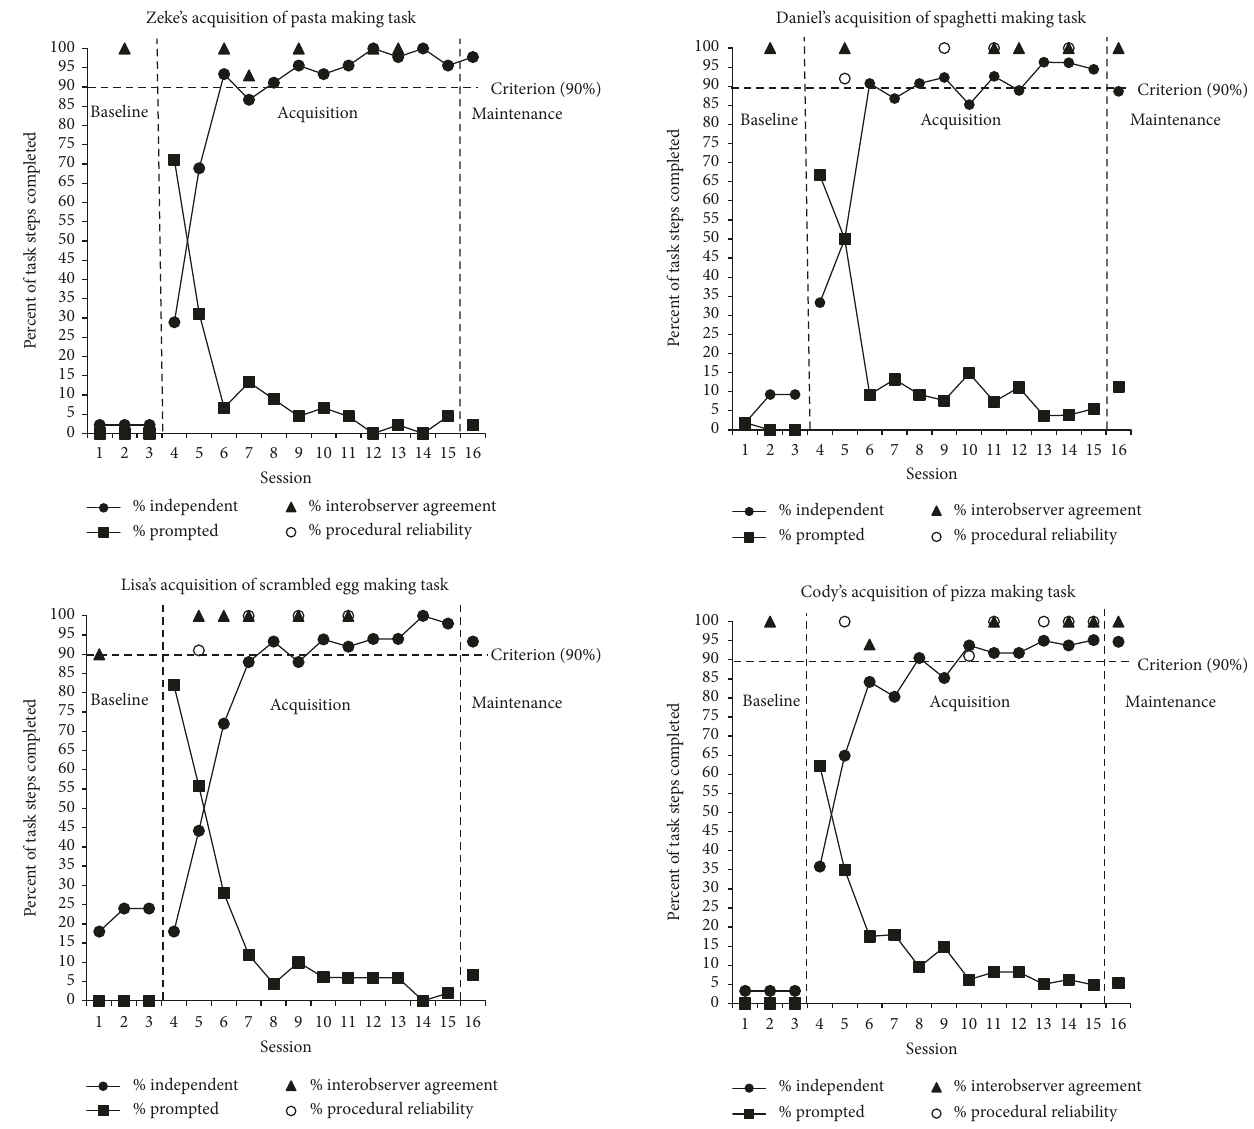
Figure 4: Percentage of task steps completed independently and with prompting: Daniel and Cody.